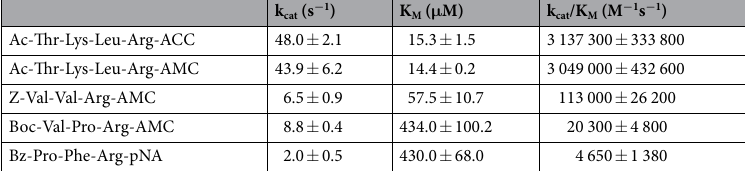
Table 1. Enzyme kinetic parameters of KLK8 with various synthetic